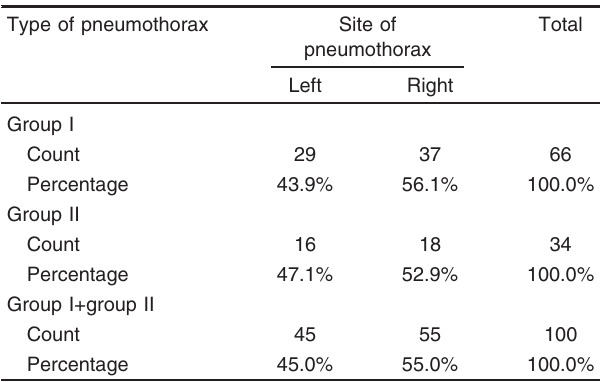
Outcome of patients with spontaneous pneumothorax Korraa et al.